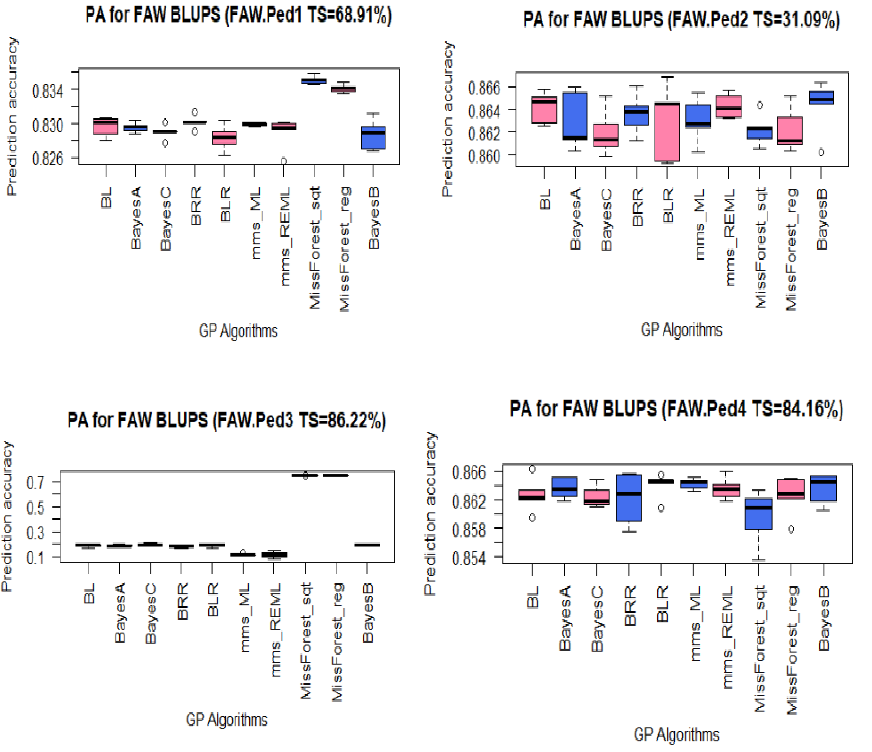
Figure 6. Boxplots of PAs for maize resistance to the fall armyworm (FAW) datasets using the PBTS approach (see Table 2 for the PBTS strategy and Table 3 for GP